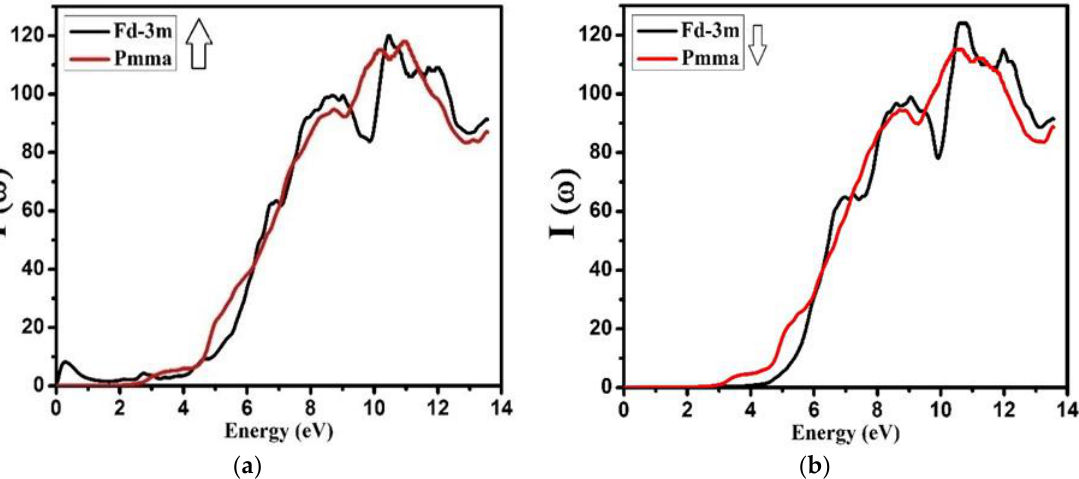
Figure 9. Calculated absorption coefficient I (ω) of Nd 2 Zr 2 O 7 ((black color for Fd-3m) and (red color for Pmma)) using GGA+U. ( a ) The spin-up direction ( ↑ ) and ( b ) spin-down ( ↓ ) direction.